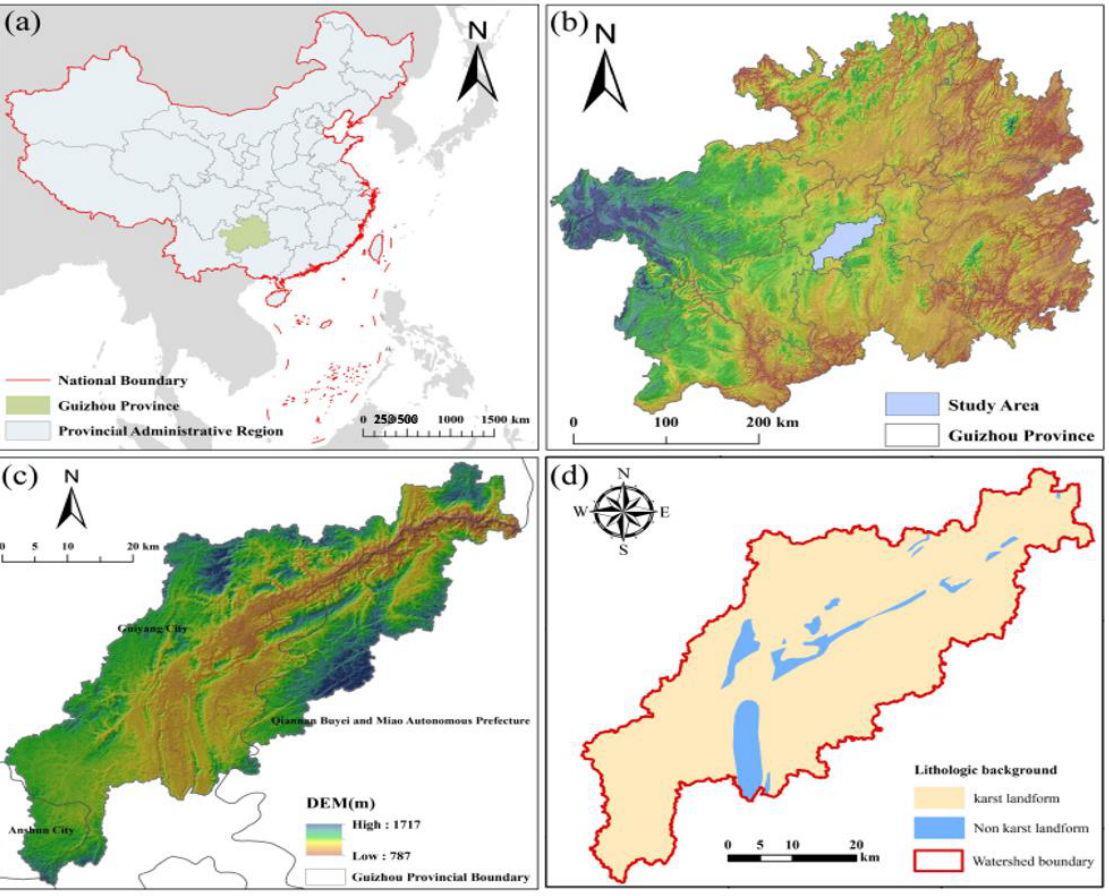
Figure 1. The basic information of the study area. Note: ( a ) shows location of Guizhou in China. ( b ) shows location of the study area in Guizhou. ( c ) shows the elevation of the study area. ( d ) shows the lithologic